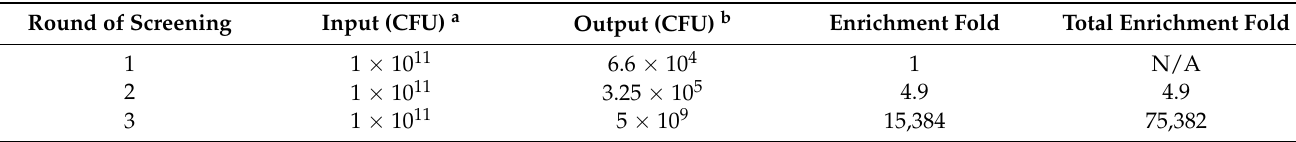
Table 2. Selective enrichment of scFv-phages by